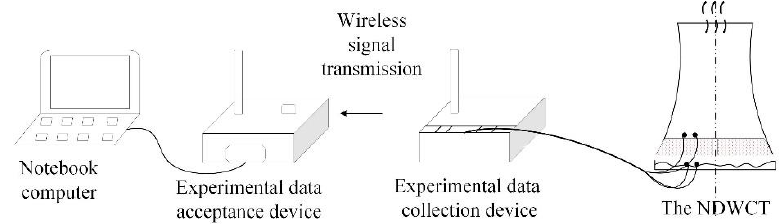
Figure 4. Sectional view of collecting basin mearing point.